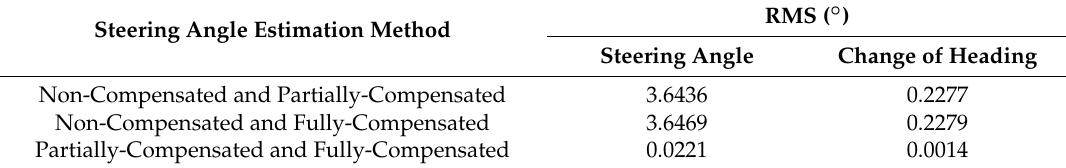
Table 1. RMS of the different steering angle and change of heading estimation methods.